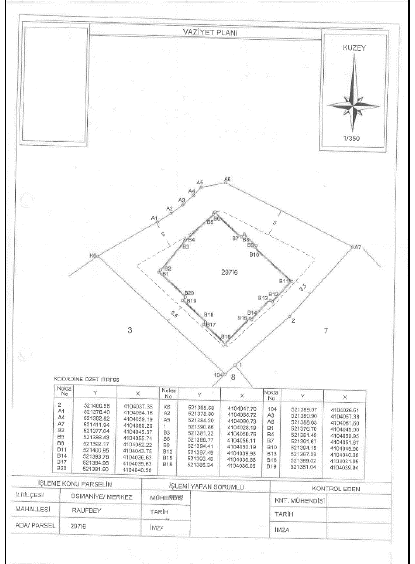
Figure 1 . Application chart (sample form Osmaniye, Turkey)